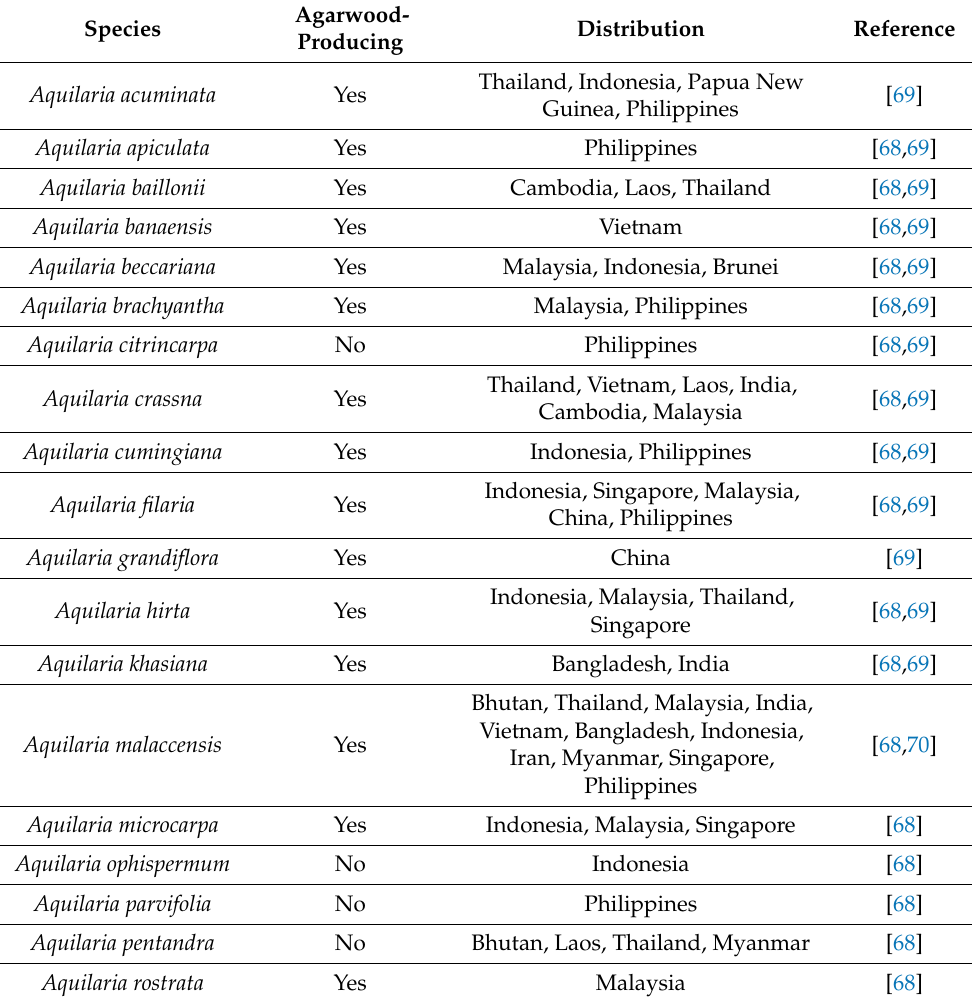
Table 2. Various species of Aquilaria and their distribution. Species Distribution Producing